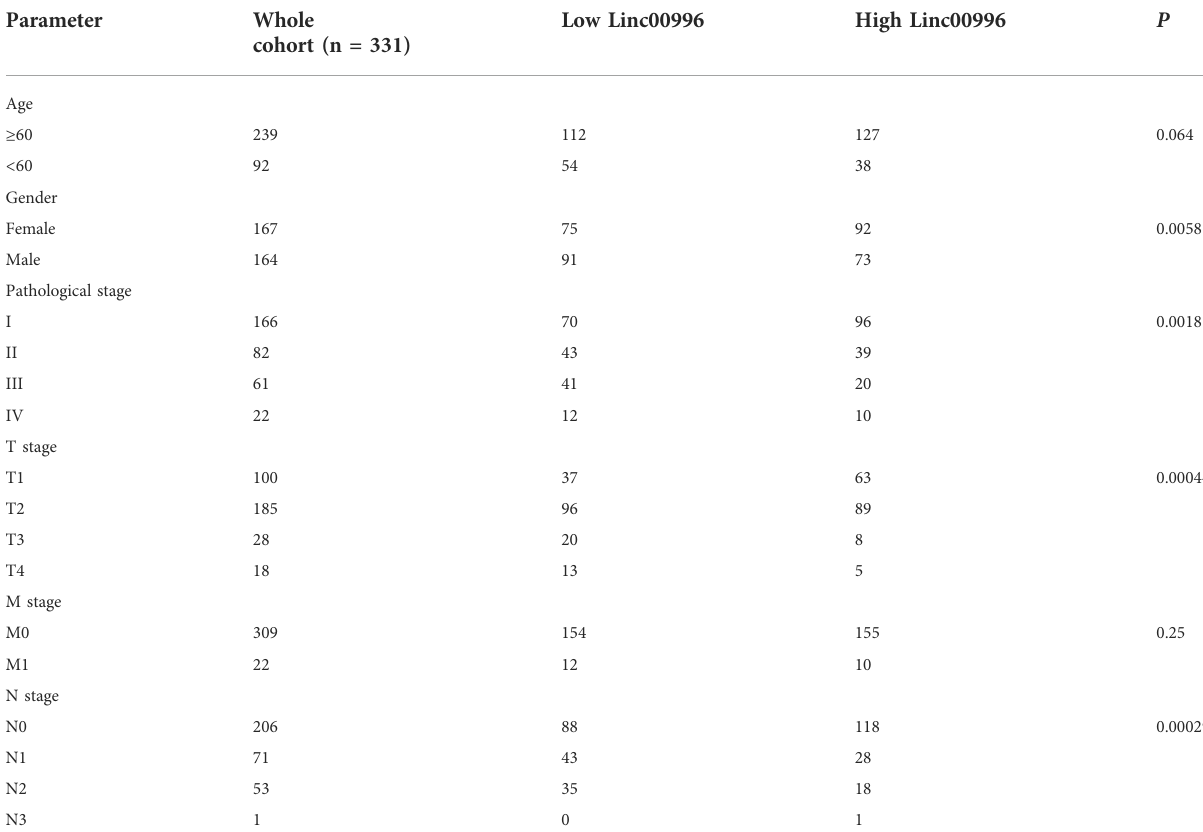
TABLE 1 Statistics of the expression of Linc00996 in TCGA-LUAD under various clinical traits.